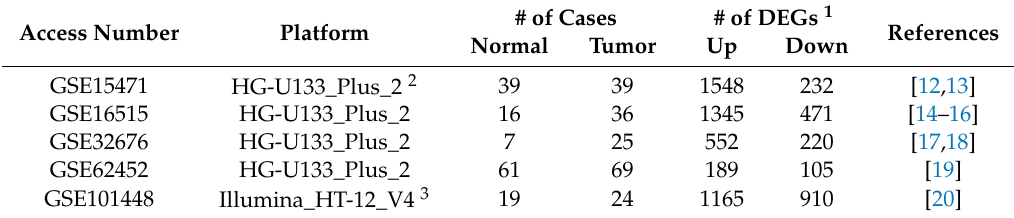
Table 1. Microarray data sets from human pancreatic cancer patients.